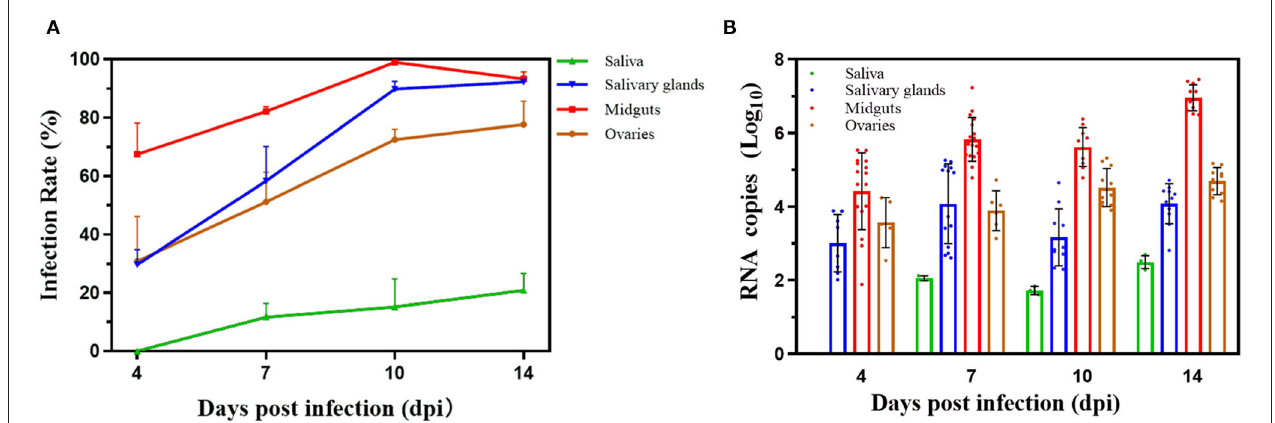
FIGURE 2 | Infection rates and virus reproduction for Zika virus in Beijing strain. (A) Vector competence of Zika virus in Beijing strain. The saliva, salivary glands, midguts, and ovaries were dissected on 0, 4, 7, 10, and 14 days post infection, and Zika virus was detected by reverse transcription quantitative real-time polymerase chain reaction. The results are expressed as mean ± SD. (B) Zika virus RNA copy number in infected saliva, salivary glands, midguts, and ovaries. Each point represents one positive tissue. X -axis represents days post infection (dpi), and Y- axis represents RNA copy number. Error bars indicate mean ± SD.